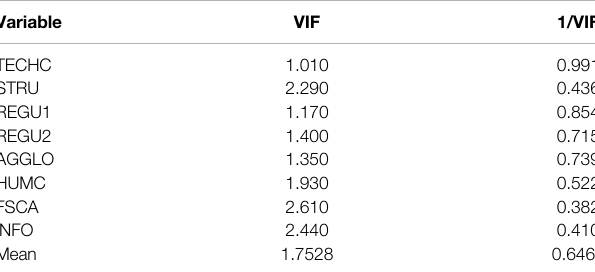
TABLE 4 | Global moran index results. TABLE 5 | Results of VIF